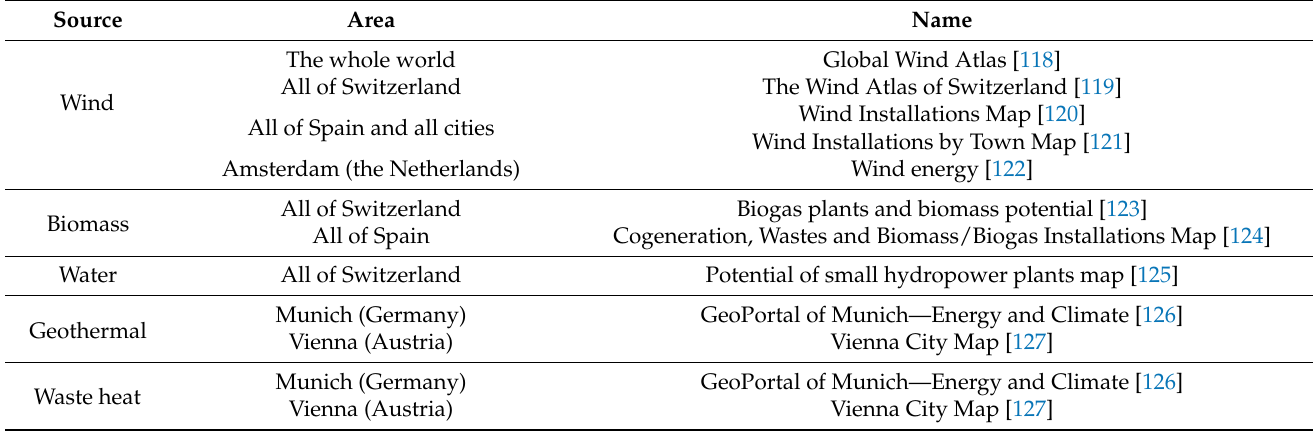
Table 5. Characteristics of selected RES cadastres (except solar